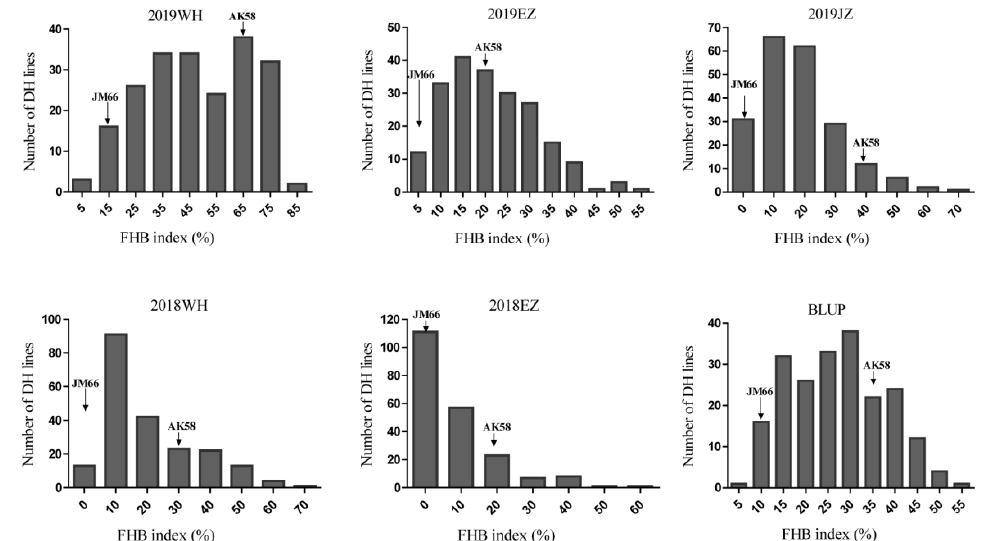
Figure 1. Frequency distribution of FHB index for 209 doubled haploid lines derived from Jingzhou66 and Aikang 58. All data are means of two replicates for each environment. Arrows indicate the disease severities of the parents. WH, Wuhan; EZ, E’zhou; JZ, Jingzhou; best linear unbiased prediction (BLUP).